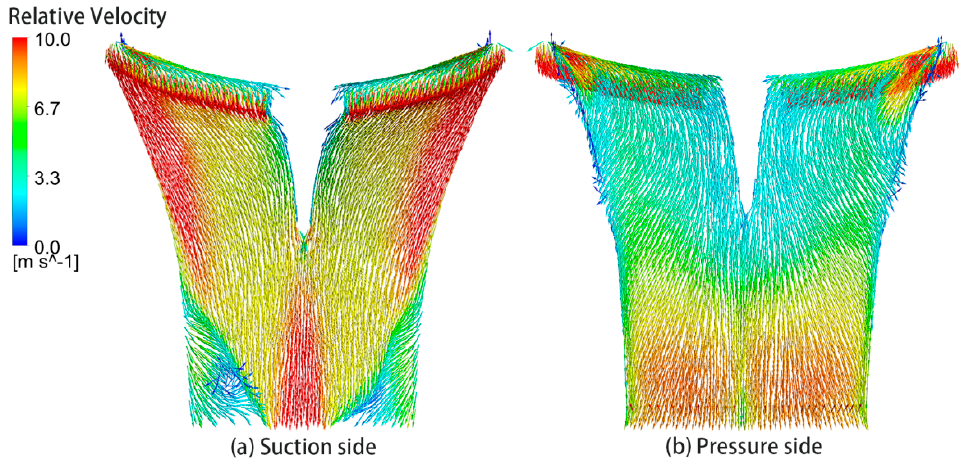
Figure 23. Relative velocity of water around the prototype blade surface (units: m/s).